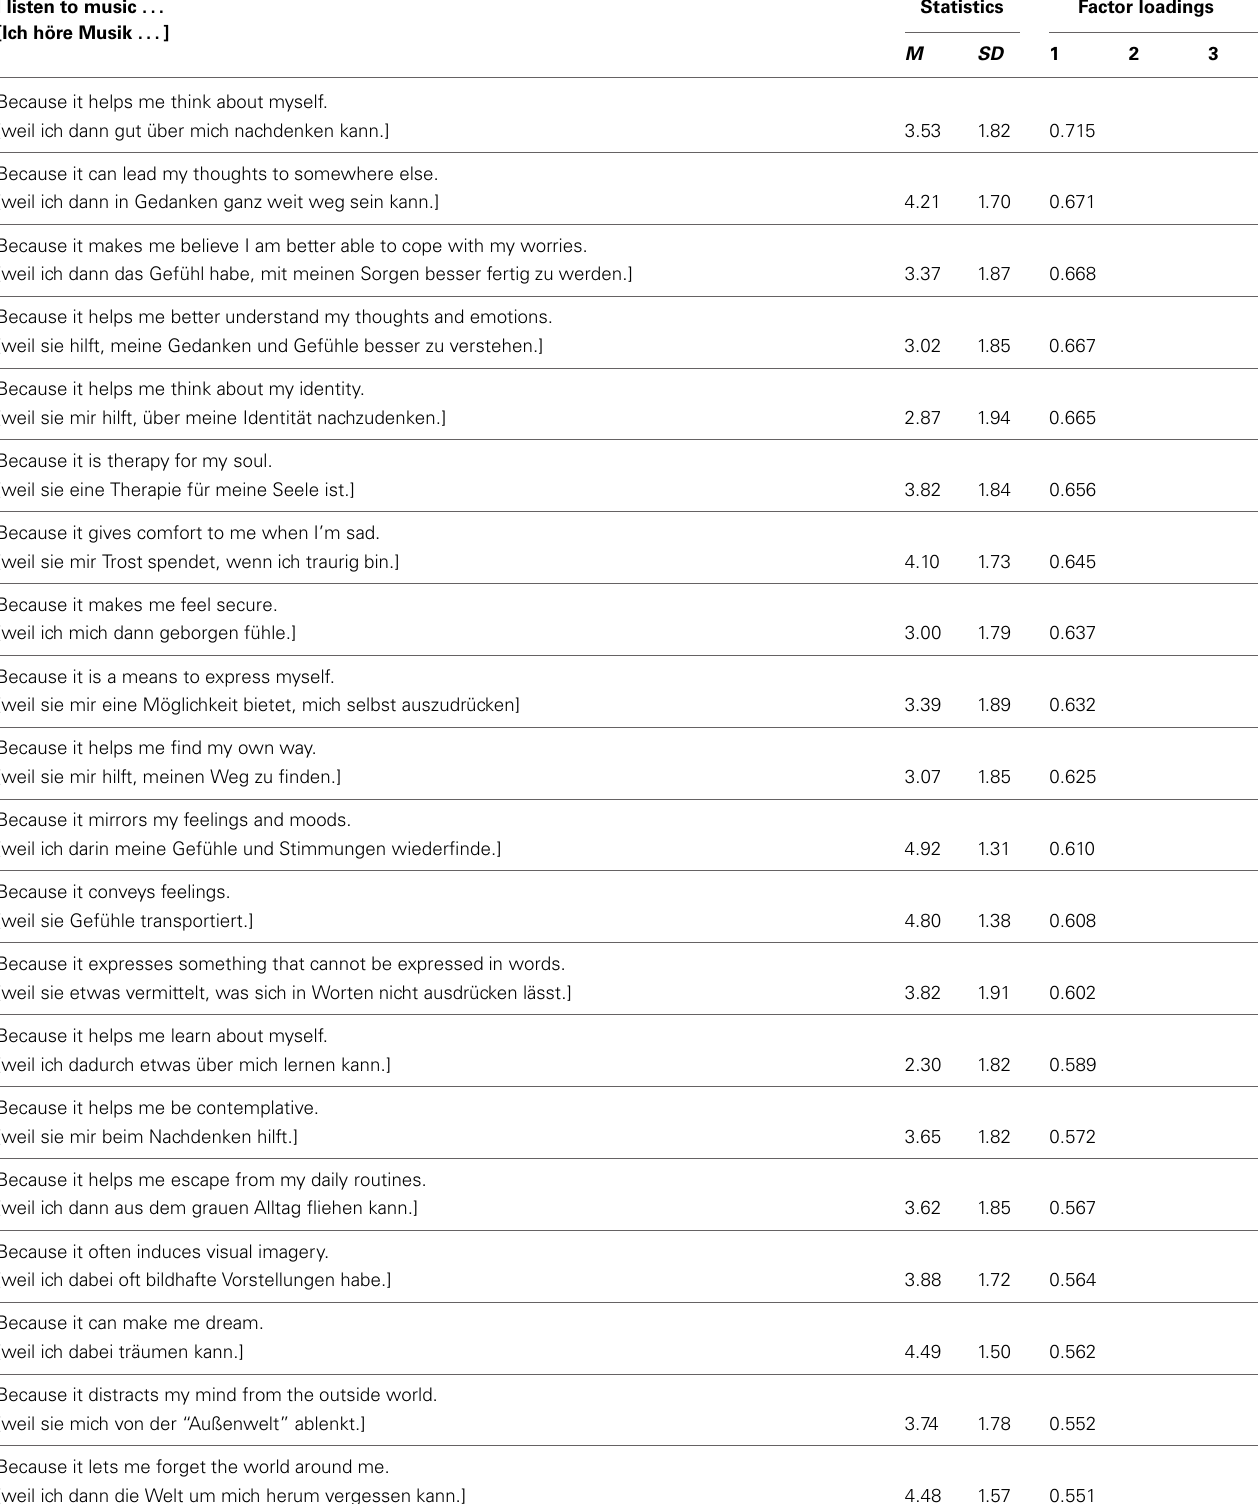
Table A3 | The 129 statements referring to the functions of music exhaustively derived from past research, together with their means, standard deviations, and factor loadings (varimax